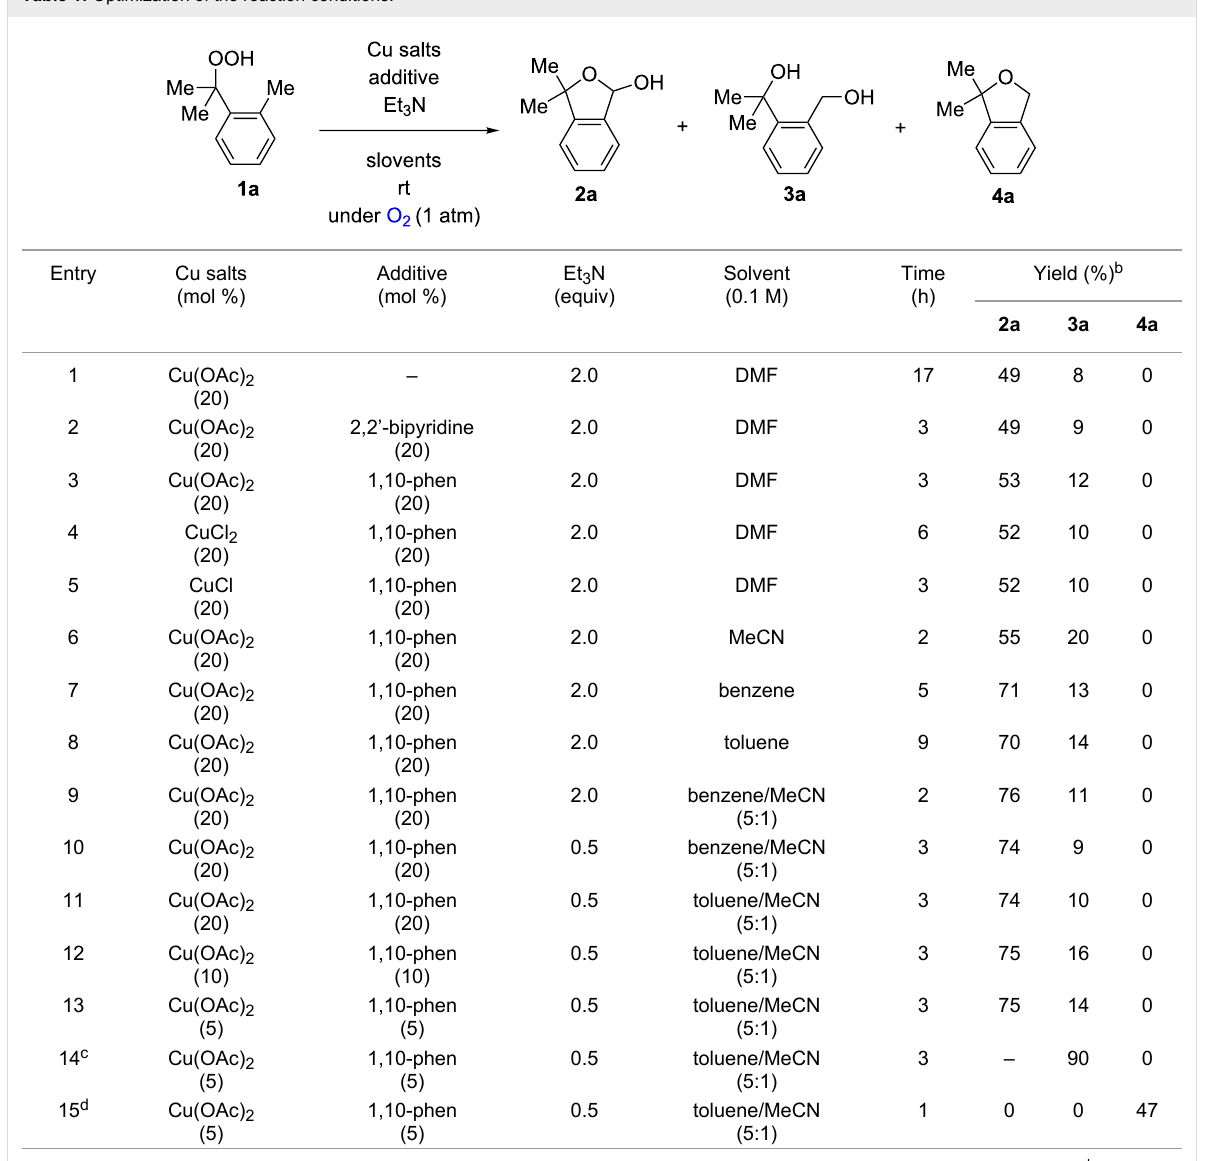
Table 1: Optimization of the reaction conditions.